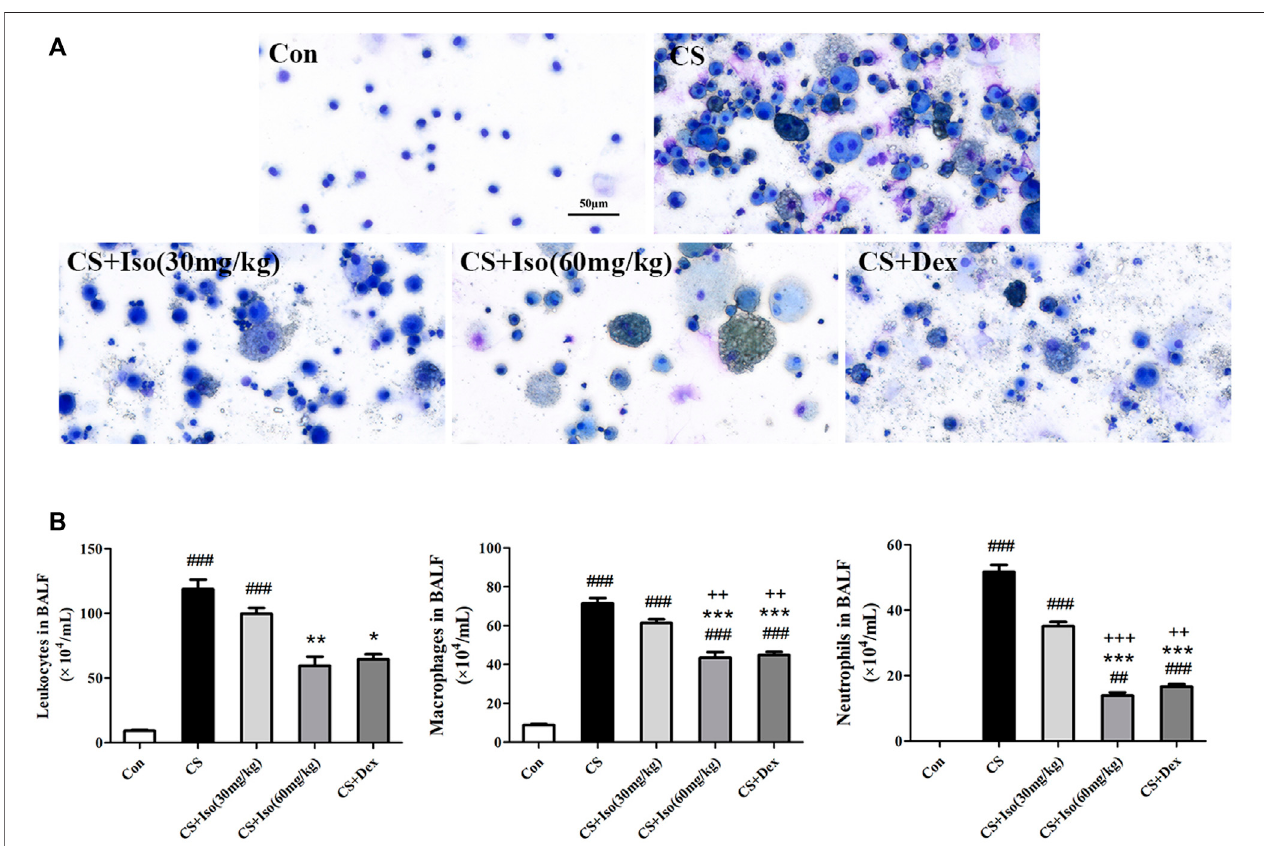
FIGURE 6 | Iso inhibits the recruitment of neutrophils and macrophages in the BALF of CS-induced COPD mice. Leukocytes in BALF were subjected to Diff-Quik staining. (A) RepresentativeimagesofleukocytesinBALFfromeachgroup(scalebar50 μ m). (B) Thenumbersoftotalcells,macrophagesandneutrophilsinBALF( n =5 mice per group). Data was shown as mean (±SD) (B) . To test for group differencses one-way ANOVA (B) was applied. ## p < 0.01, ### p < 0.001 vs. control group, * p < 0.05, ** p < 0.01, *** p < 0.001 vs. CS group and ++ p < 0.01, +++ p < 0.001 vs. CS + Iso 30 mg/kg